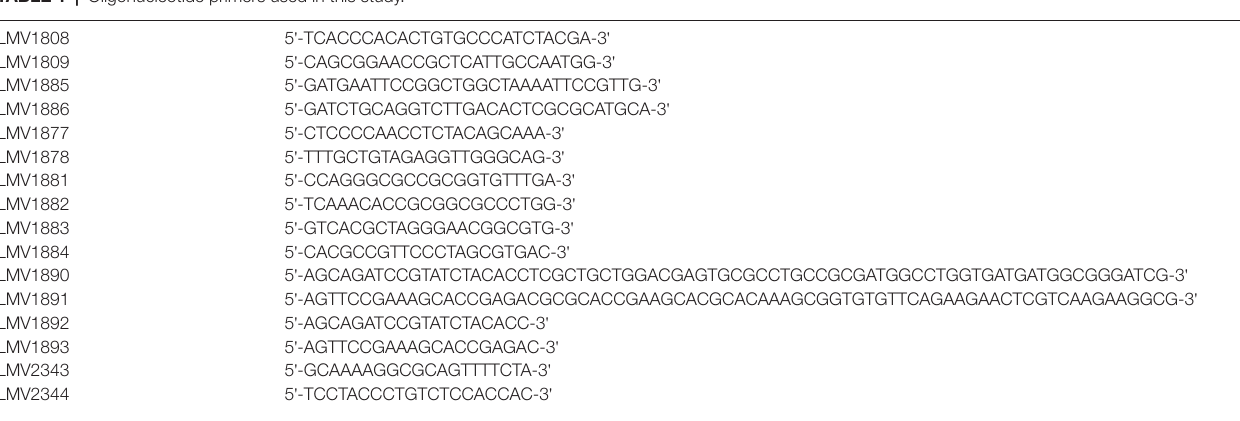
TABLE 1 | Oligonucleotide primers used in this